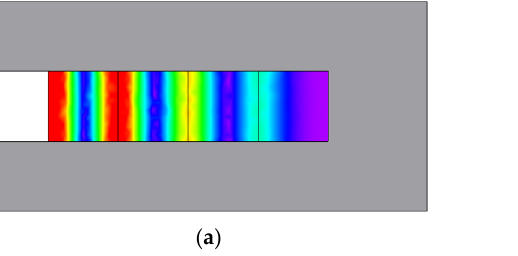
Figure 4. Slot-level current density contour plot of four-layer conductors with two types of phase arrangements (80 Apk, 2 kHz): ( a ) Phase arrangement: AAAA; ( b ) Phase arrangement: ABAB.